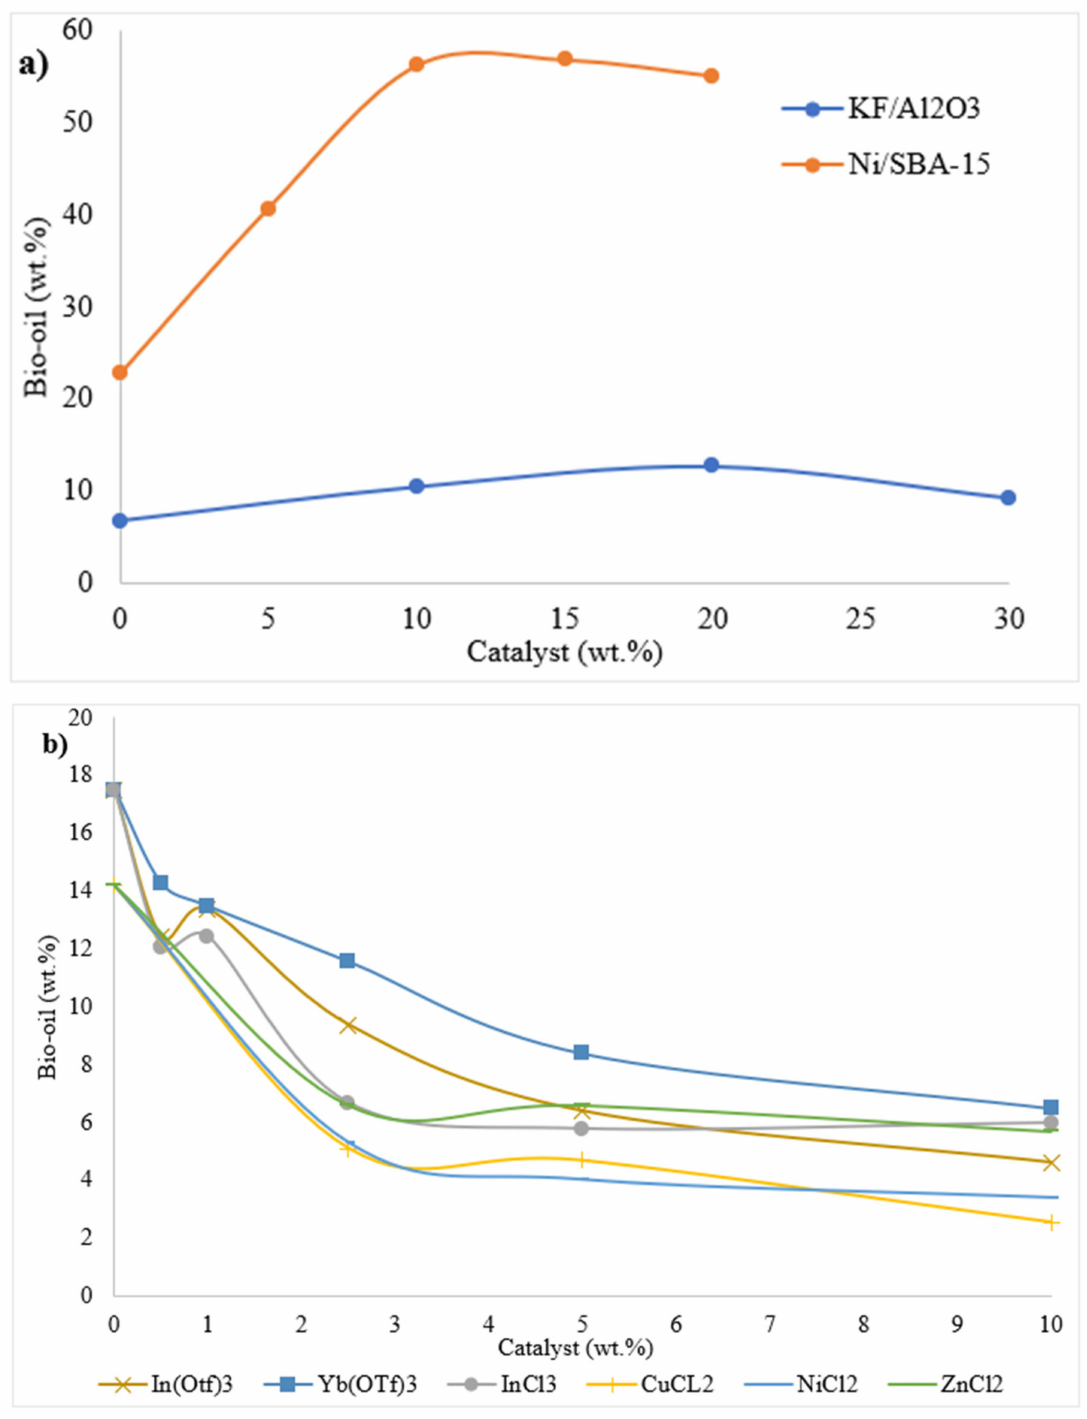
Figure 9. Effect of heterogeneous catalyst concentration on the yield of bio-oil ( a ) catalyst with positive effect, ( b ) catalyst with negative